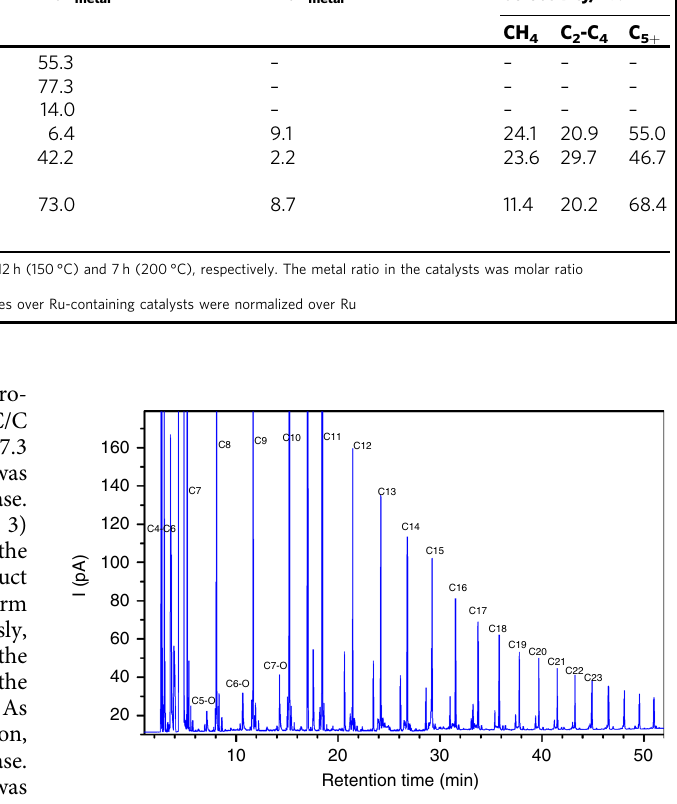
Table 1 Catalytic performance of aqueous-phase CO conversion with different catalysts Entry